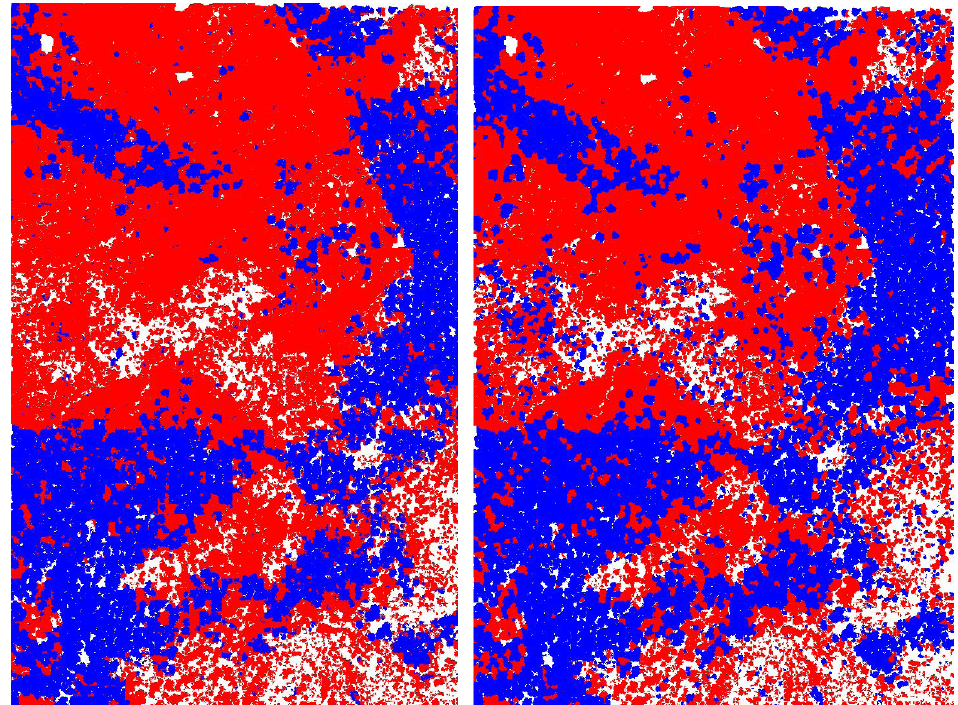
Figure 4. Semantic labeling result ( left ) and reference data ( right ) for coniferous trees (blue) and deciduous trees